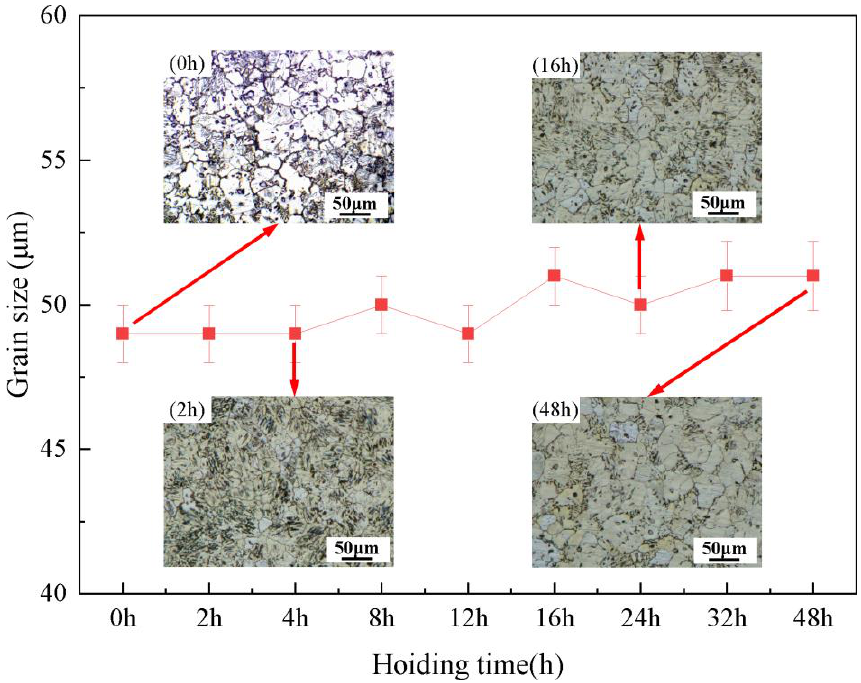
Figure 8. Changes in grain size of the Mg-3Y-4Nd-2Al alloy with different solution times.